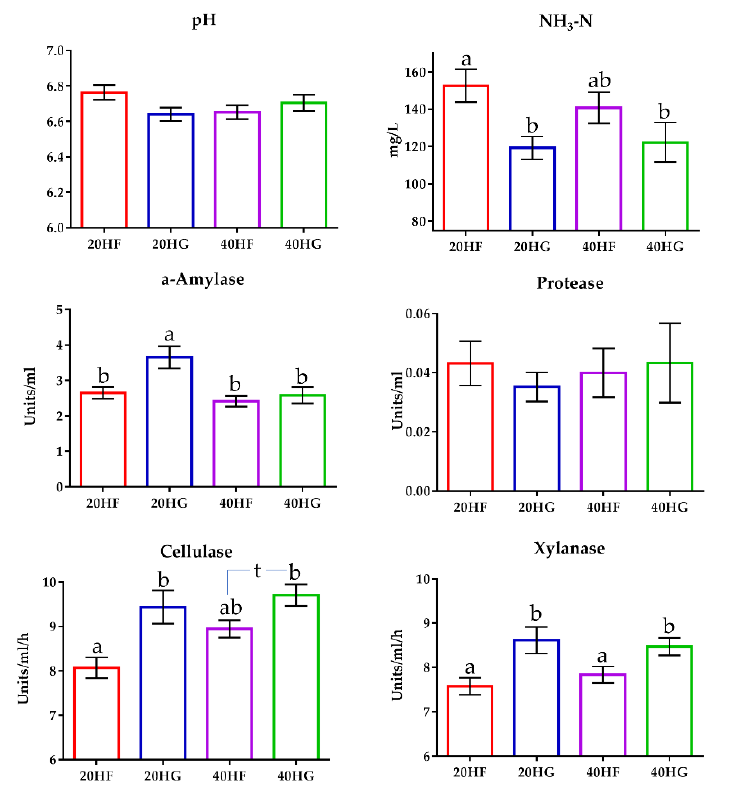
Figure 5. The mean ruminal pH, ammonia concentration, a-amylase, protease, cellulase, and xy- lanase activity of goats fed diets (20HF, 20HG, 40HF, and 40HG) with different levels of microalgae Schizochytrium spp (20 g and 40 g/day/goat) and two different forage to concentrate ratios (60:40 and 40:60) throughout the experimental period (21st and 42nd experimental day) illustrated in bar graphs ± SEM. Bars with different superscript (a, b) between dietary treatments differ significantly ( p ≤ 0.05) according to the Analysis of Variance (ANOVA) using a general linear model for repeated measures and Post hoc analysis was performed when appropriate using Tukey’s multiple range test. Additional statistics investigating the interaction of microalgae level, forage to concentrate ratio, and the sampling time effect are available in Tables S7 and S8. 20HF (n = 11 goats): 20 g Schizochytrium spp. and high forage diet (60:40); 20HG (n = 11 goats): 20 g Schizochytrium spp. and high grain diet (40:60); 40HF (n = 11 goats): 40 g Schizochytrium spp. and high forage diet (60:40); 40HG (n = 11 goats): 40 g Schizochytrium spp. and high grain diet (40:60).